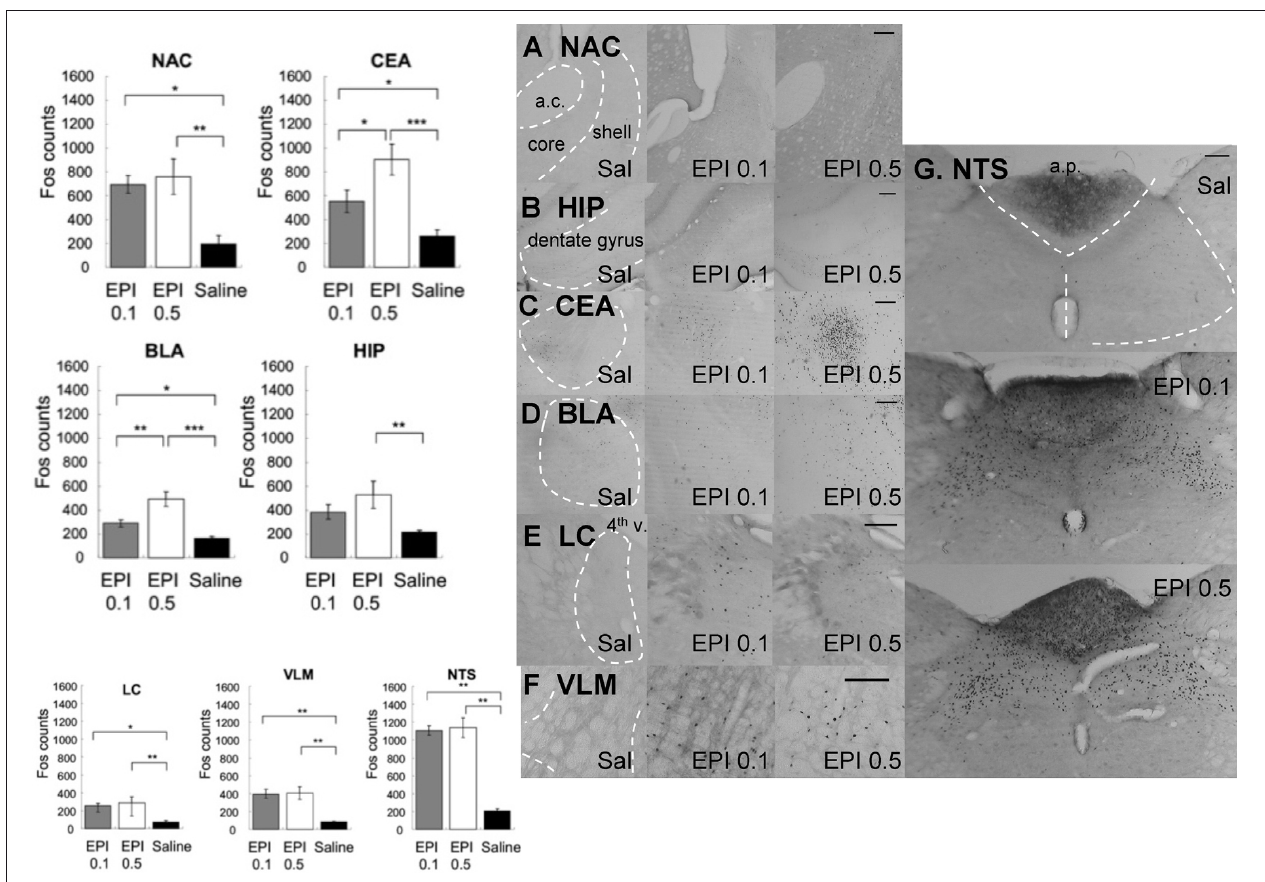
FIGURE 7 | Systemic injection of epinephrine induced significantly more Fos-like immunoreactivity in the NAC, CEA, BLA, HIP, LC, VLM, AP, and NTS. Because injection was given systemically and no hemisphere difference was found, Fos counts from both hemisphere were collapsed. ( ∗ , ∗∗ , and ∗∗∗ denotes significant difference between the compared groups with a p -value less than 0.05, 0.01, and 0.001, respectively). Photomicrographs of Fos